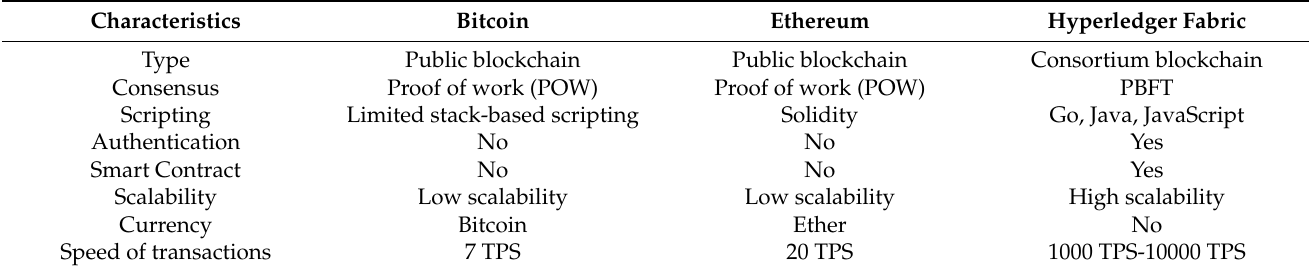
Table 4. Comparison of the three blockchain